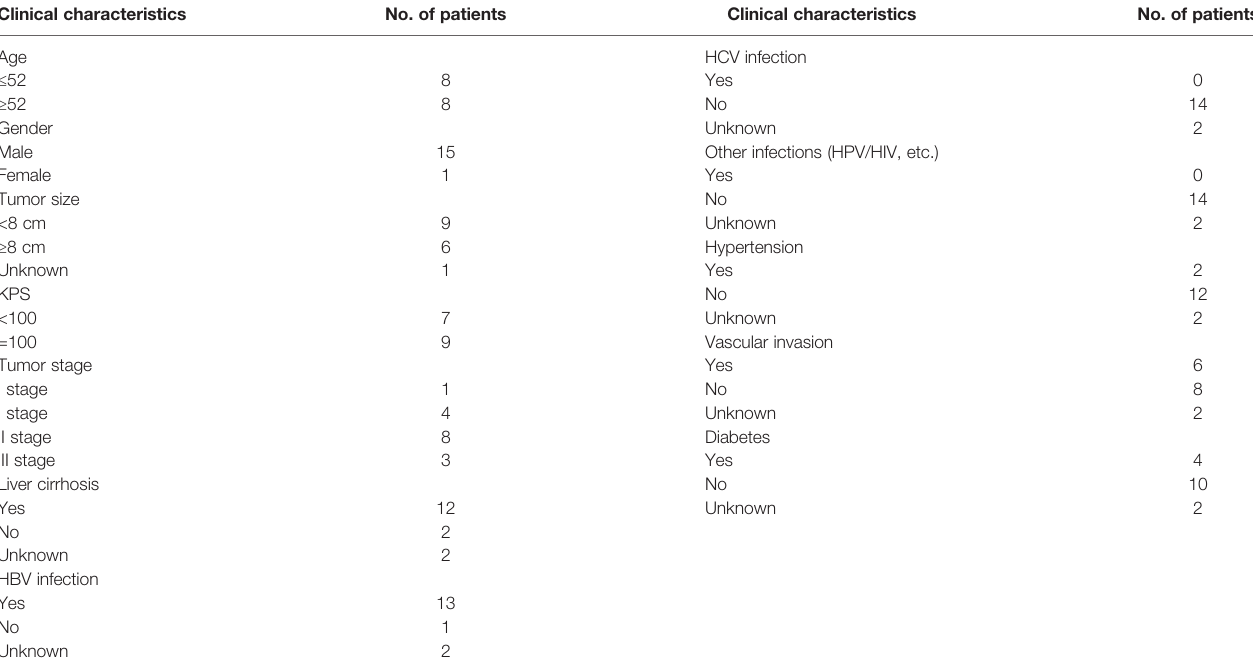
TABLE 1 | Clinical characteristics of 16 enrolled liver cancer